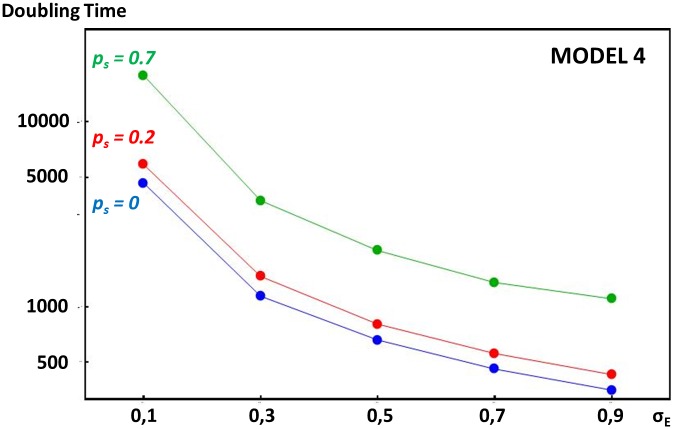
Comparative rate of enhancer strength escalation in models with or without self-fertilization.Axes and simulation methods are the same than for Fig 4. Selfing rate p
s is 0, 0.2 and 0.7 on blue, red and green curves, respectively. In all three cases, enhancer strength escalation is faster with larger mutational variance σE
2 on the enhancer locus. Self-fertilization slows down the ER process.